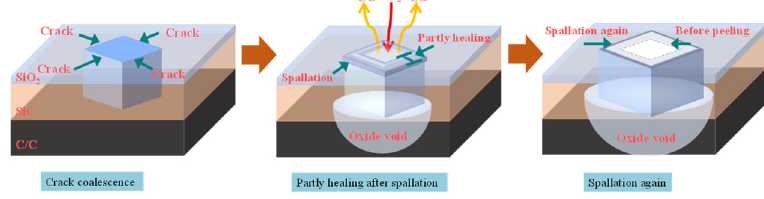
Figure 12. Schematic diagram of the failure process for SiC coating.